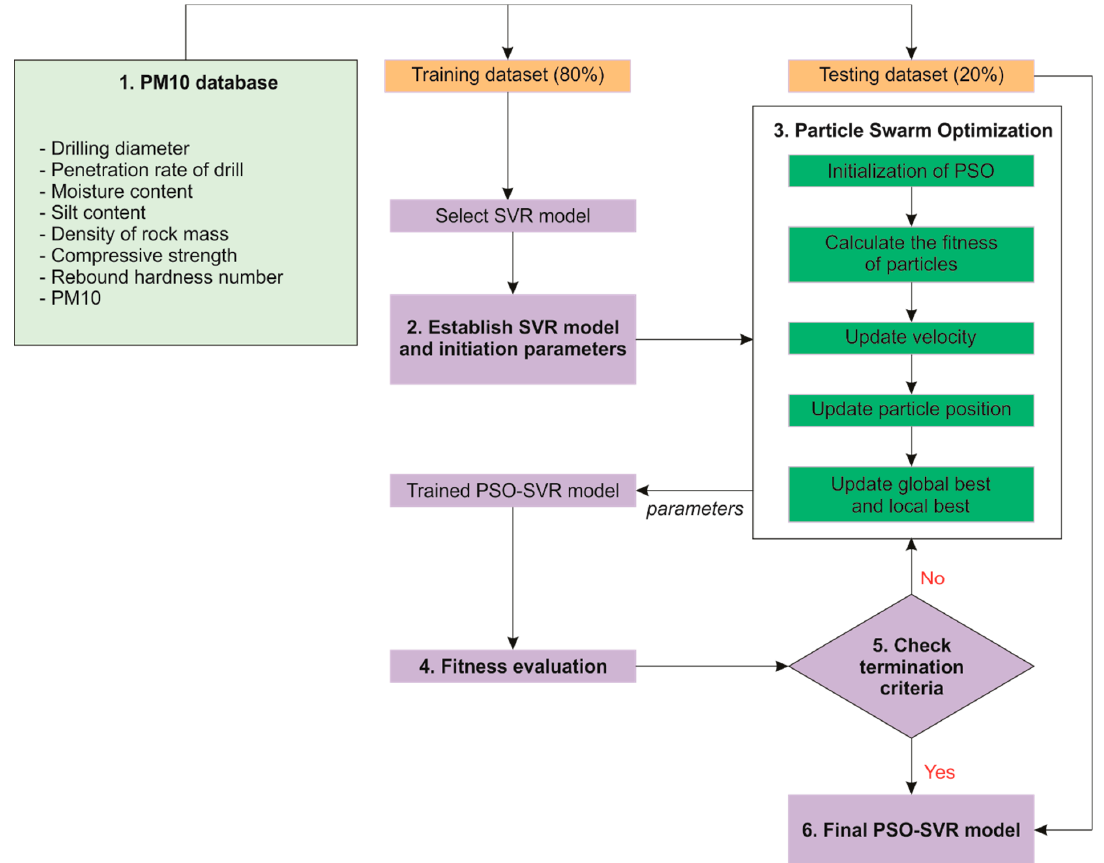
Figure 11. Proposing the PSO-SVR model for estimating PM 10 concentration.